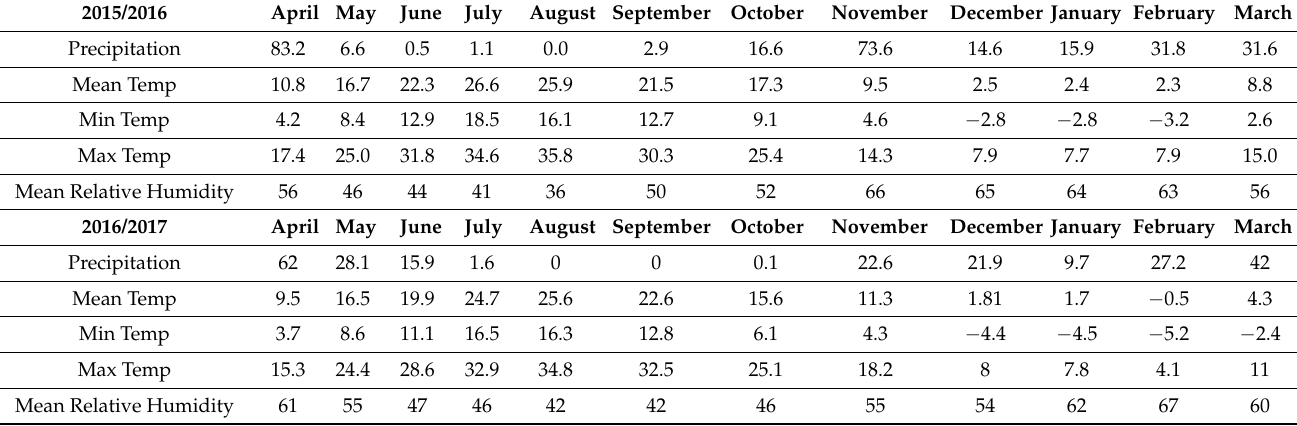
Table 2. Average meteorological monthly data of Zanjan Agricultural Research Station in the two years of experiment on saffron response to four PGR applications in 2015/2016 and